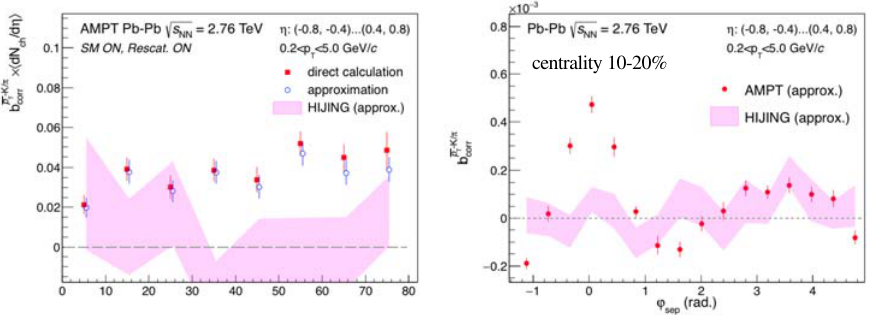
Figure 3. Forward-backward correlation strength b p − K /π corr in Pb–Pb collisions in AMPT as a function of collision centrality, scaled by charged particle density ( left panel), and as a function of the distance ϕ sep between the two azimuthal windows in 10-20% centrality class ( right panel). Results from HIJING are shown as filled bands. Kinematic ranges are indicated on the